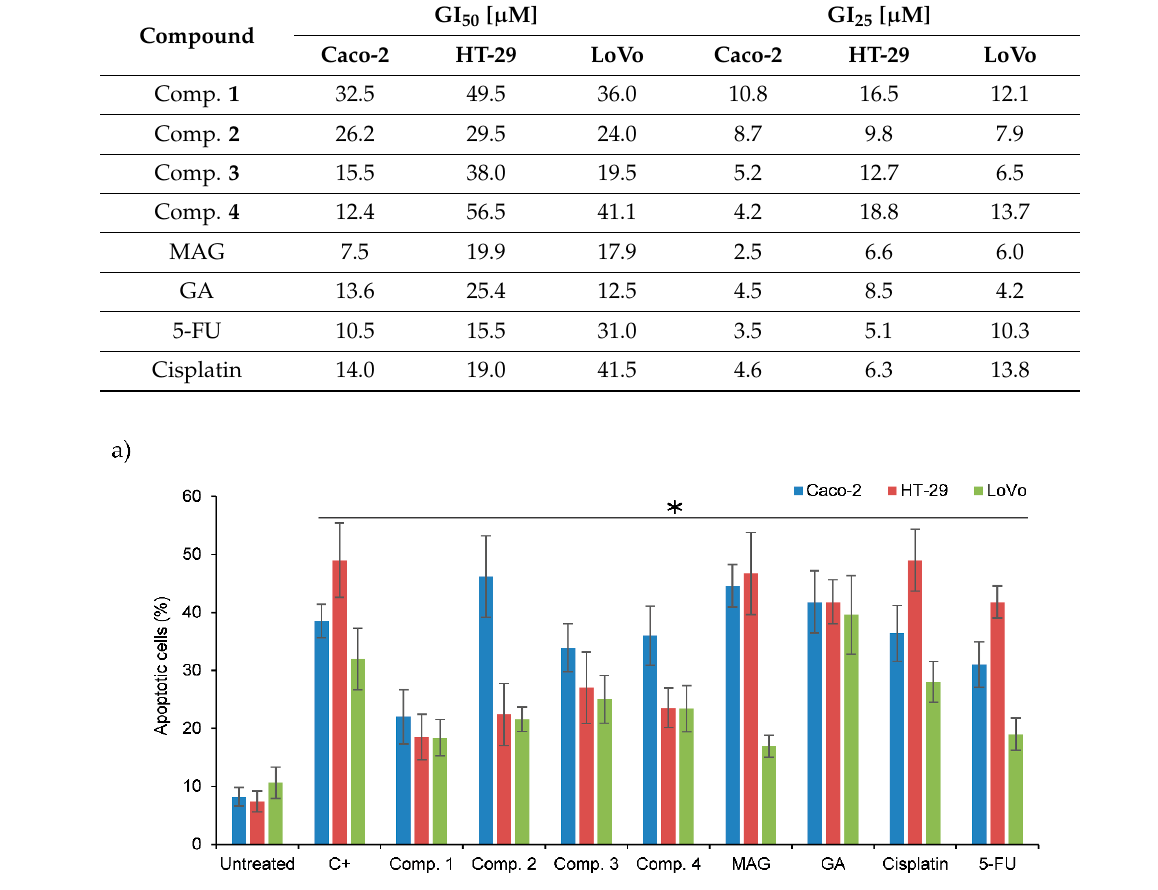
Table 3. Comparison of GI 50 and GI 25 values for the synthetic xanthone derivatives MAG and GA (reference xanthones), as well as the reference chemotherapeutic drugs cisplatin and 5-FU, as determined by MTS assay for colon tumor cell lines after 24 h treatment.